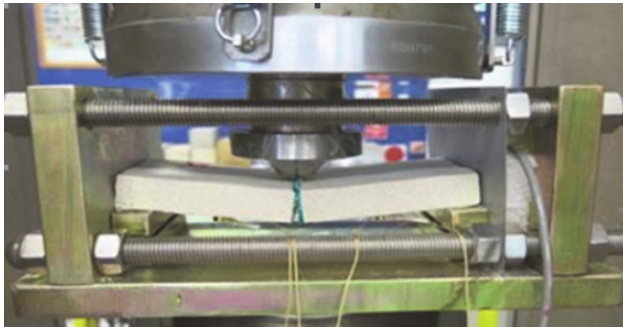
Figure 1: The concentrated loading test for rock plate.